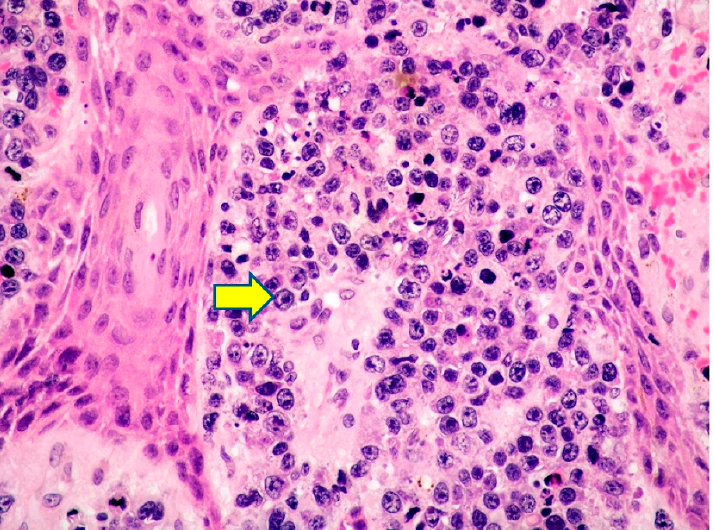
Figure 11. Cutaneous localization of PBL: high-power view highlighting the cytological details of the dermal neoplastic infiltrate, made up of large-sized cells with often evident nucleolus (yellow arrow pointing towards a large PBL cell with prominent nucleolus) (HE, magnification 200×; original image by Prof. S.A.).